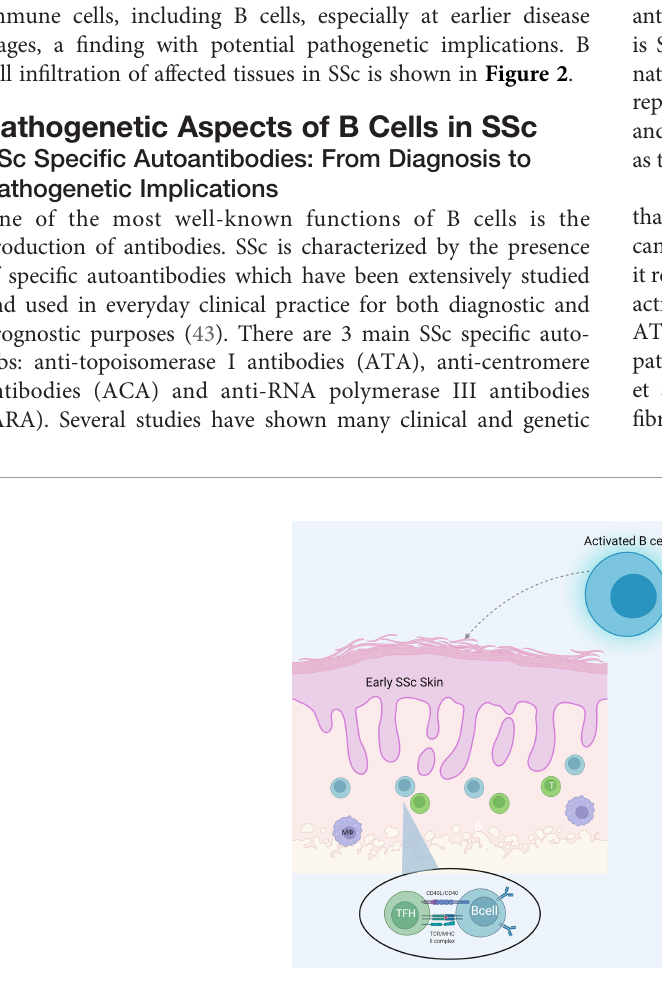
FIGURE 2 | B cell in fi ltration of the target organs skin and lung in SSc. B cells are more evident in early skin lesions and interact locally with T cells resembling ectopic lymphoid